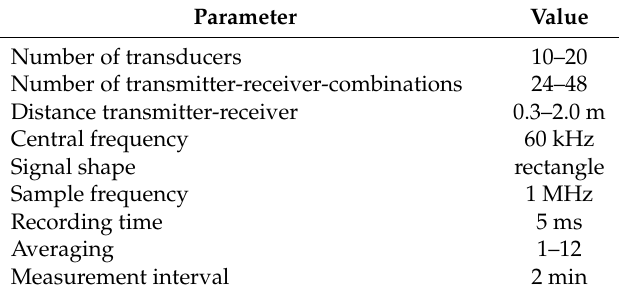
Table 1. Ultrasonic measurement parameters.